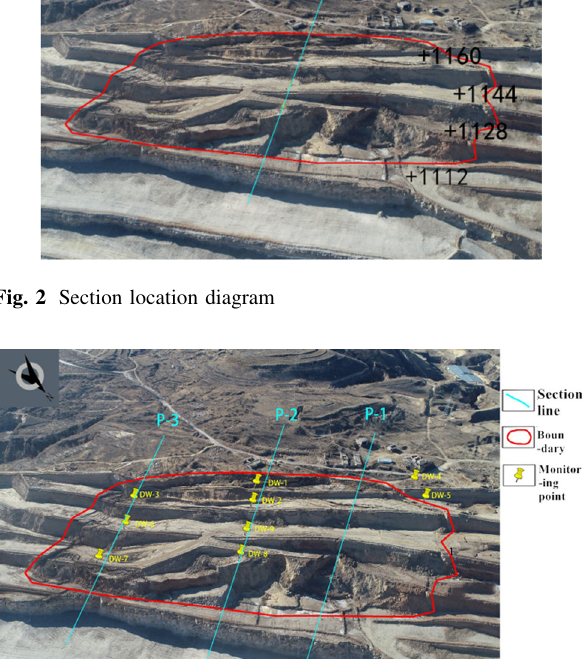
Table 1 Cumulative displacement values of GPS monitoring points in landslide area Point Cumulative horizontal No. displacement